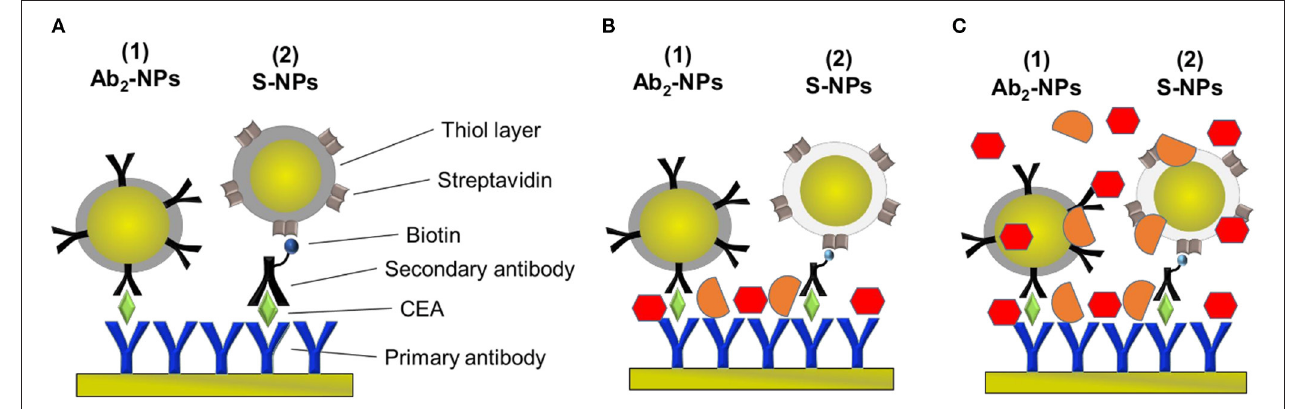
FIGURE 2 | Schematic of the sandwich-assays using two types of functionalized NPs for the detection of CEA in the three different conditions studied in this paper. (A) Assay: Primary antibody immobilized on the sensor surface, incubated with EA in PBS BSA and either NP functionalized with the secondary antibody specific for CEA (Ab 2 -NPs) or secondary antibody and NPs functionalized with streptavidin (S-NPs) binding to the biotinylated Ab 2 B. (B) Assay: Analogous to (A) except for that the sensor is exposed to plasma after CEA capture. (C) Assay: Analogous to (A) except for that the functionalized NPs are contained in blood plasma.